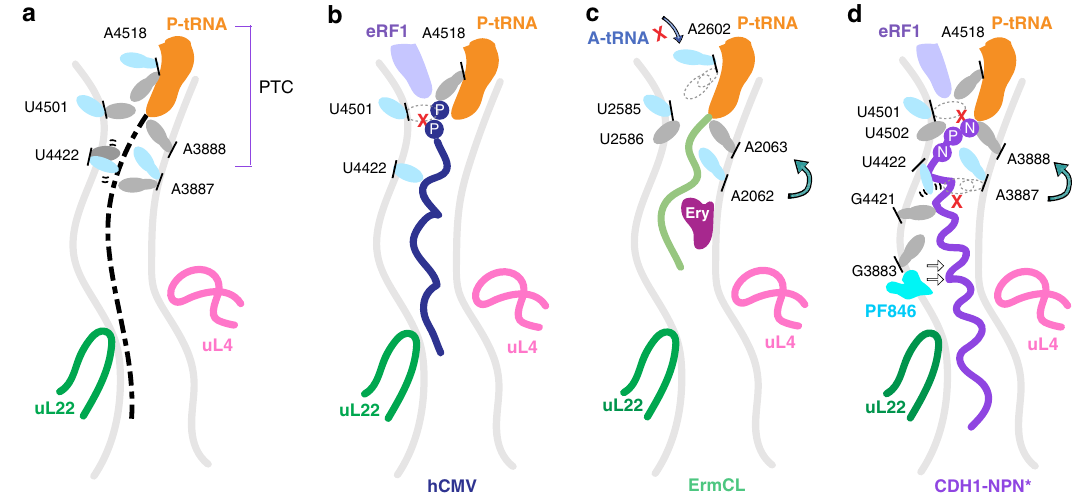
Fig. 5 Features of PF846-mediated inhibition of translation termination. a Schematic of common translation stalling features, with 28S rRNA nucleotides showing conformational changes (gray, translation-competent conformation; light cyan, inactive conformation). Nucleotides are shown with human numbering, with the corresponding E. coli numbering in parentheses as follows: A4518 ( Ec A2602), U4501 ( Ec U2585), U4422 ( Ec U2506), A3888 ( Ec A2063), and A3887 ( Ec A2062). b Schematic showing hCMV nascent-chain-induced stalling of translation termination 10 . The critical amino acid P – P motif for hCMV-mediated stalling is indicated. U4501 is fl ipped away from the PTC to avoid a steric clash with the C-terminal motif, leading to inhibition of PTC catalysis. c Schematic representing drug-dependent stalling of ErmCL in bacteria 30,33 . A2602 blocks the accommodation of A-site tRNA, and U2585 fl ips